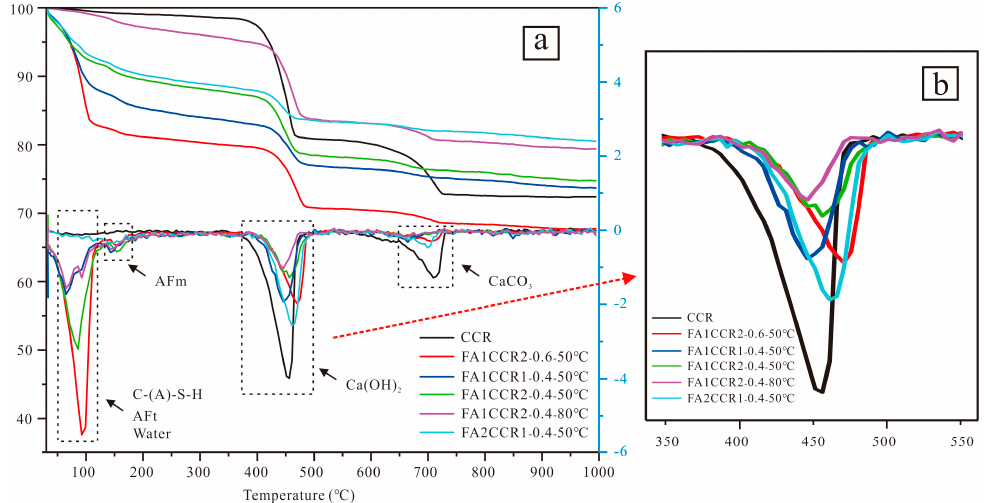
Figure 6. ( a ) The TGA and DTG curves of CCR and the FA/CCR-based geopolymers. ( b ) the enlarged scale between 350–550 °C of DTG curve.